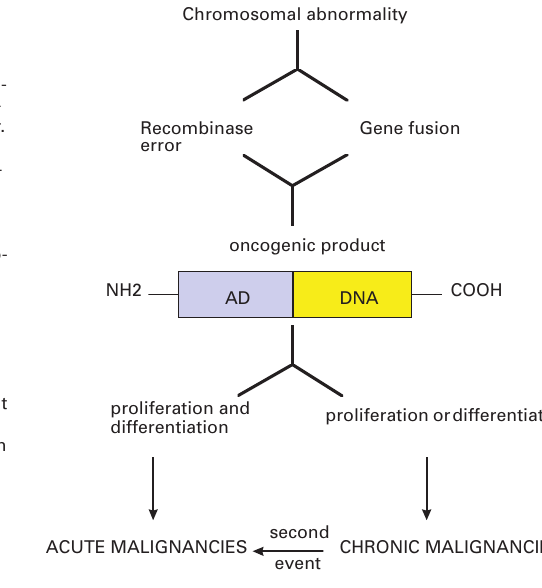
Schematic view of a recurrent molecular consequence of chro- mosomal abnormali- ties in human cancer. The creation of a chromosomal abnor- mality results in an oncogenic protein in the mutant cell. The structure of such pro- teins is usually com- posed of a transcrip- tional activation capacity (AD) asso- ciated with a DNA- binding domain (DNA-BD). As a result of this chimeric pro- tein, cell proliferation and cell differentia- tion control can be affected in leukaemias and malignant solid